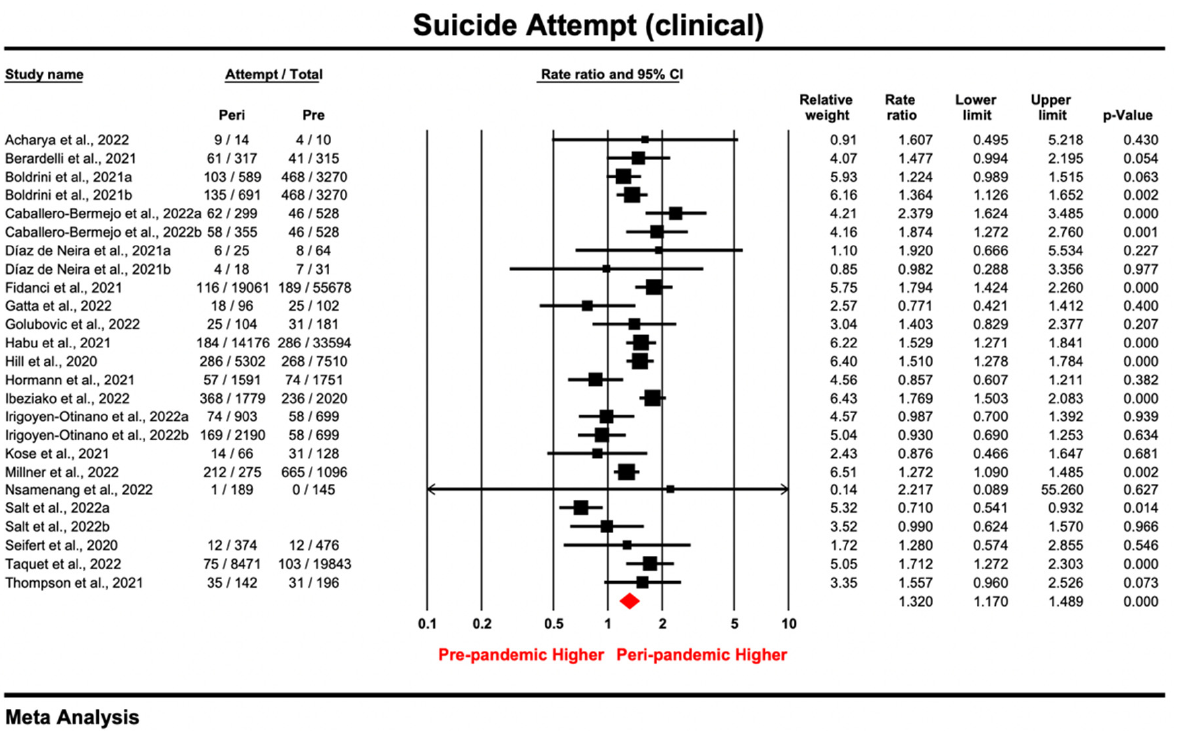
Figure 5. Forest plot for suicide attempt of studies [16,65,67,69–71,73,92,94–96,101,103–107,109–111] conducted in the clinical setting (Prismatic colored as red refers to the pooled estimate).